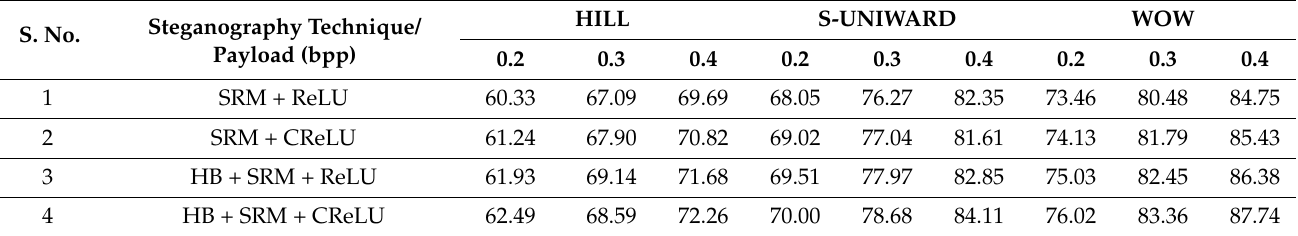
Table 2. Performance analysis of a high-boost filter and CReLU